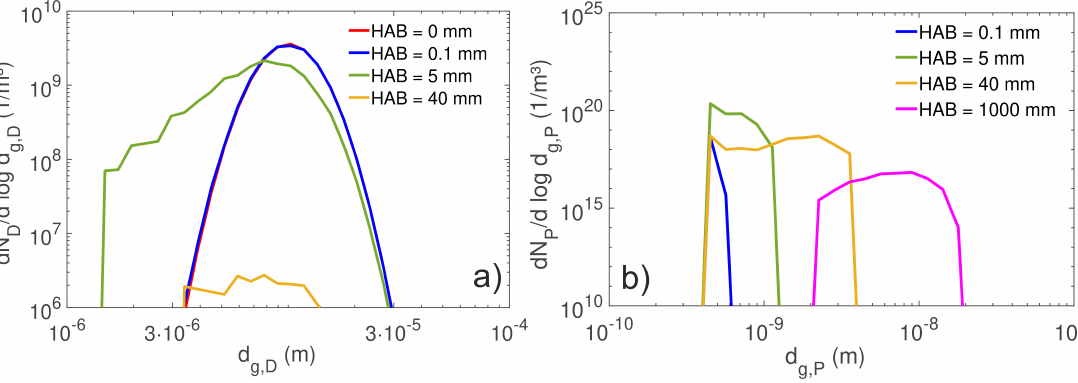
Figure 8. Evolution of the droplet size distribution (DSD) ( a ) and particle size distribution (PSD) ( b ) over HAB. Droplet-and particle-only regions exist at the beginning and at the end of the simulation, respectively. A mixed zone in the lower flame region exists where both droplets and particles are